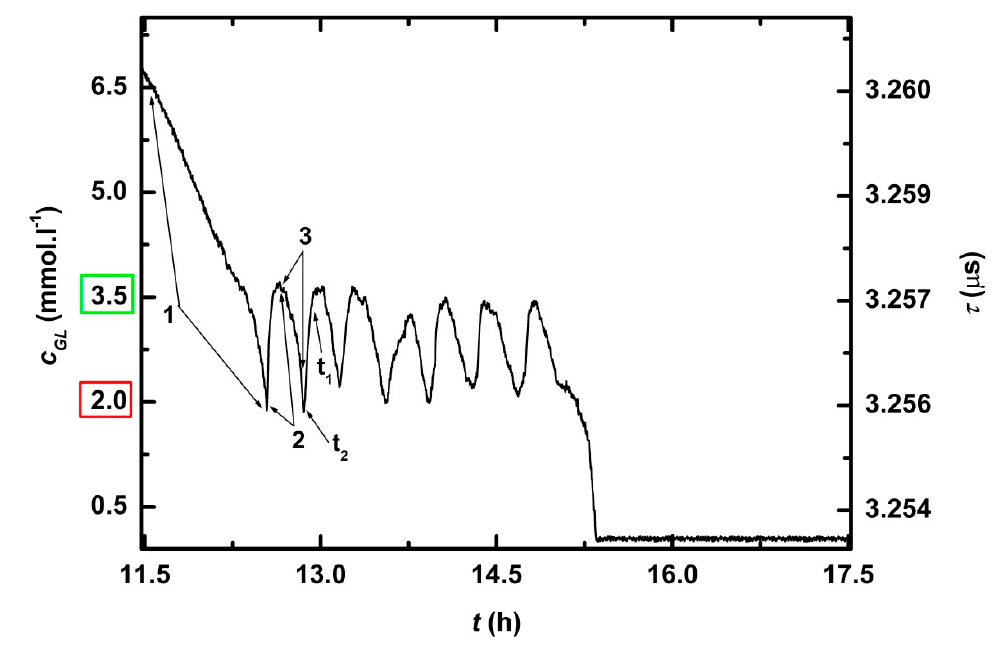
Figure 6. Detailed time record of feedback regulation of glucose concentration during stationary phase of cultivation of Saccharomyces cerevisiae.